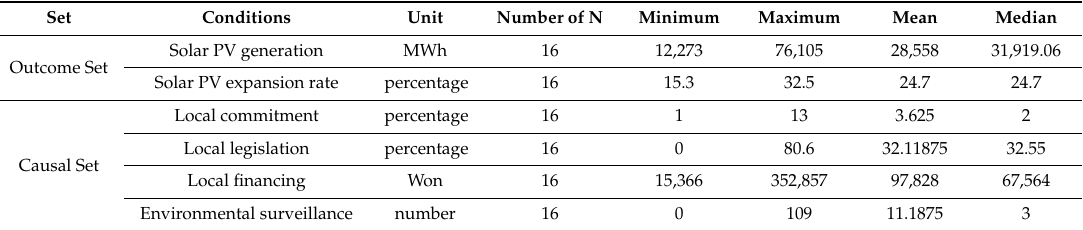
Table A2. Descriptive statistics of